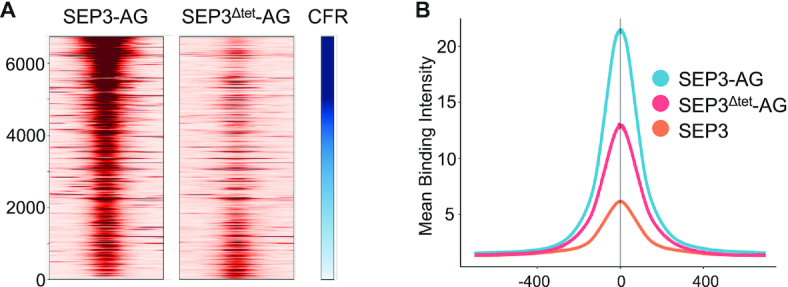
Binding comparisons for seq-DAP-seq datasets. (A) Heat map of read intensity for SEP3–AG (left) and SEP3Δtet-AG (right) with dark red indicating highest number of reads. Peaks are sorted by CFR on the y-axis (CFR ranging from 16.45 to 0.37, with highest CFR in dark blue); x-axis is a 1000 bp window for each peak. (B) Mean binding intensity of seq-DAP-seq peaks for SEP3–AG (blue), SEP3Δtet-AG (pink) and SEP3 (orange). X-axis is number of bp from the peak center at 0. The mean binding intensity is normalized to read count.